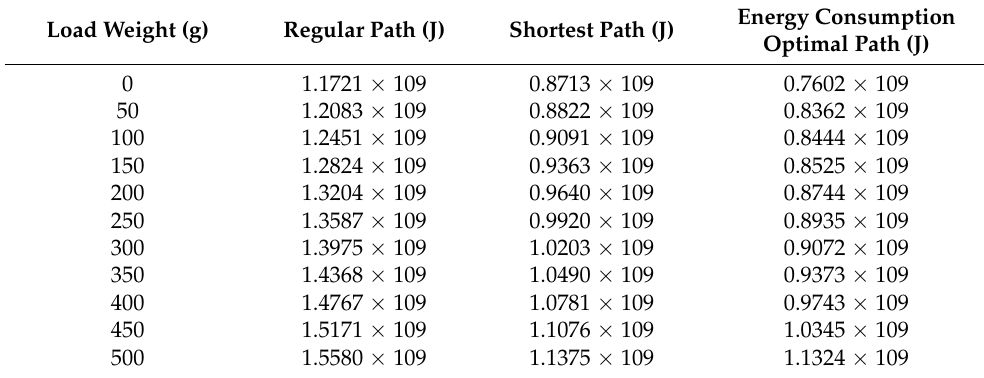
Table 3. Total energy consumption of UAV flight under different paths.